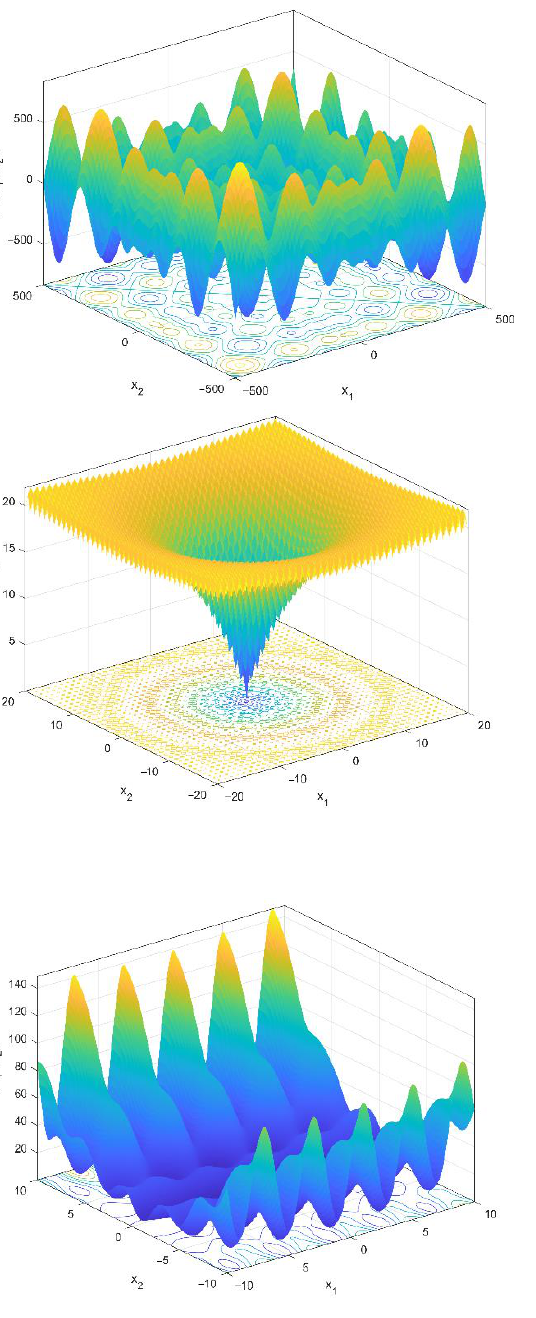
Figure 3. 3-D versions of multimodal benchmark functions.